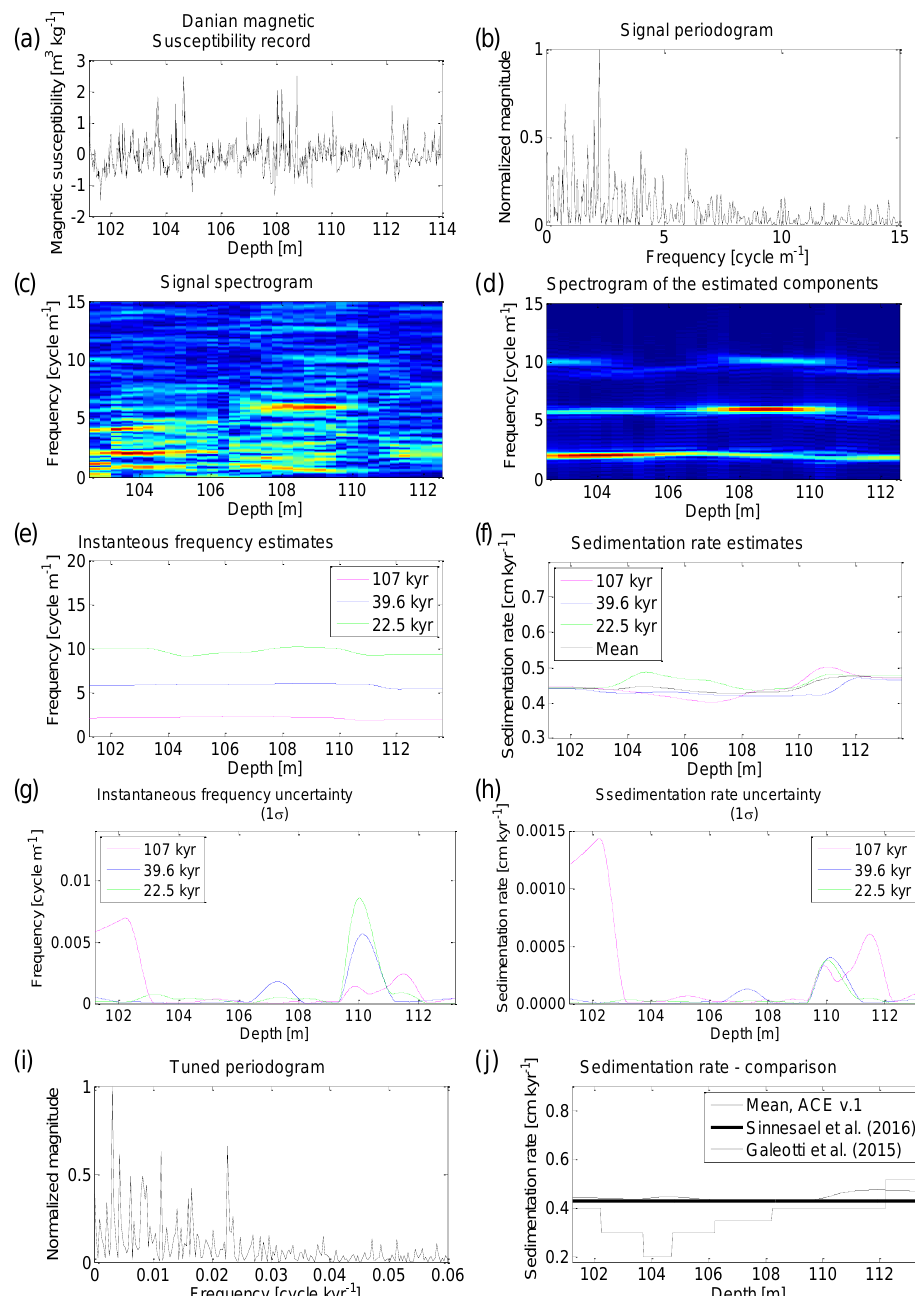
Figure 4. ACE v.1 analysis for a Danian magnetic susceptibility record. (a) Contessa Highway Danian magnetic susceptibility record (m 3 kg − 1 ) (Sinnesael et al., 2016). (b) The periodogram of the Danian magnetic susceptibility as plotted in Fig. 2a. (c) The spectrogram of the Danian magnetic susceptibility record. (d) The spectrogram of the three modeled components (100kyr eccentricity, 39.6kyr obliquity and 22.5kyr precession) using ACE v.1 (Berger et al., 1992). (e) Estimated instantaneous frequencies for the three modeled components. (f) Using the associated (astronomical) periods of the modeled frequencies, the corresponding sedimentation rate is calculated. (g) The un- certainties on the estimated instantaneous frequencies (1 σ) . (h) The uncertainties on the sedimentation rate estimates (1 σ) . (i) Periodogram of time series of the signal where the mean sedimentation rate estimate is used to make the conversion to the time domain. (j) Comparison between the ACE v.1 estimated sedimentation rates and the derived sedimentation rates in the studies by Galeotti et al. (2015) and Sinnesael et al.